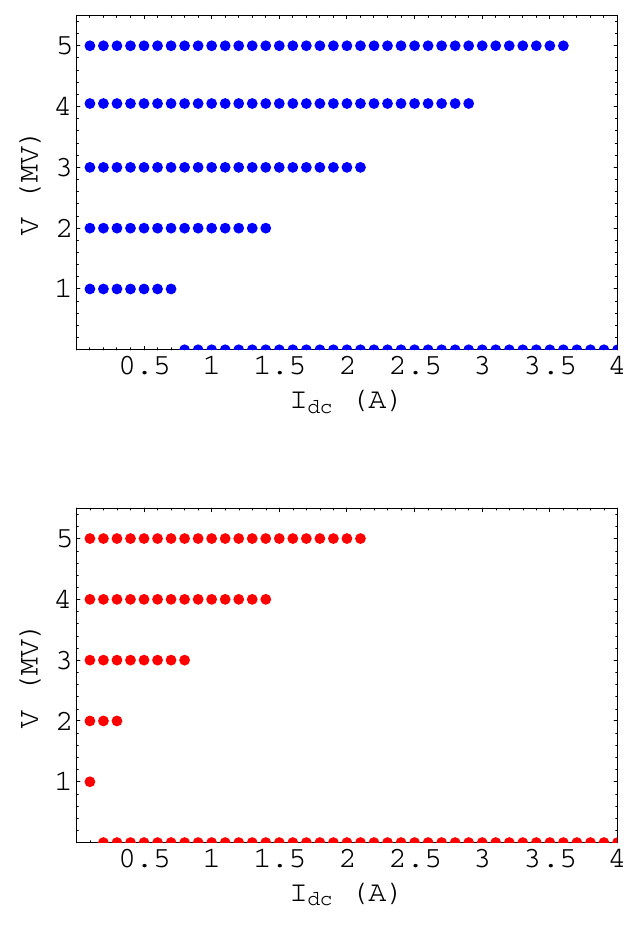
FIG. 4. (Color) For each rf voltage of the PEP-II LER, the beam currents corresponding to Robinson criterion of stability are shown by dots. Upper plot: with the FB H (cid:4) 6 : 0 ; bottom plot: with the FB turned off, H (cid:4) 0 .